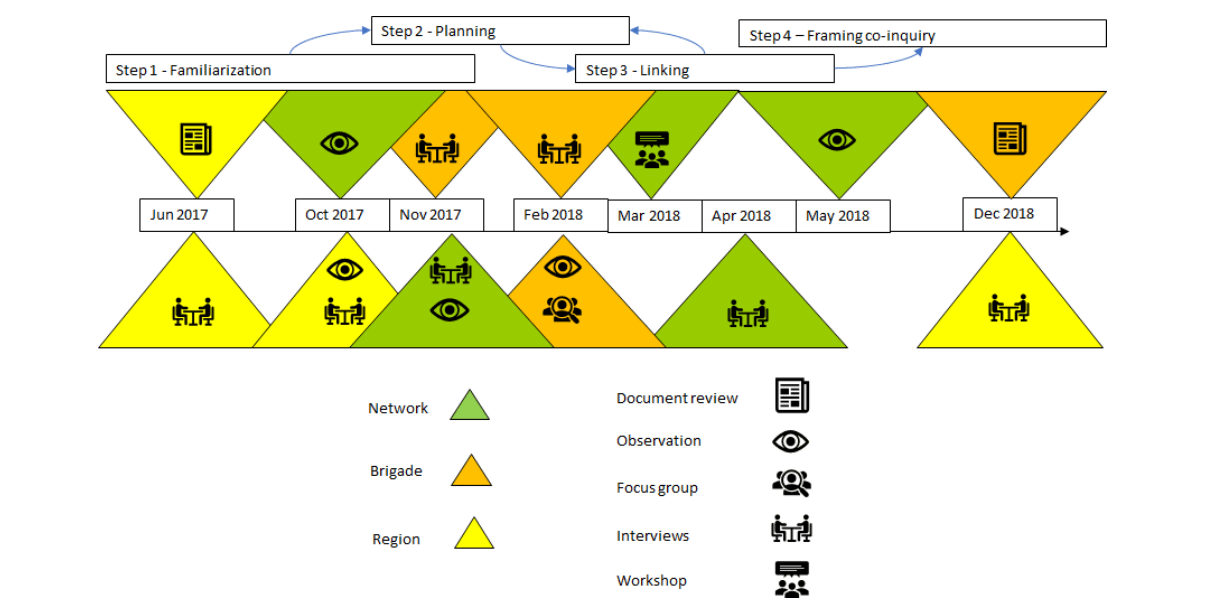
Fig. 4 . Time line of research engagements alongside co-inquiry steps for developing a systemic co-inquiry (Box